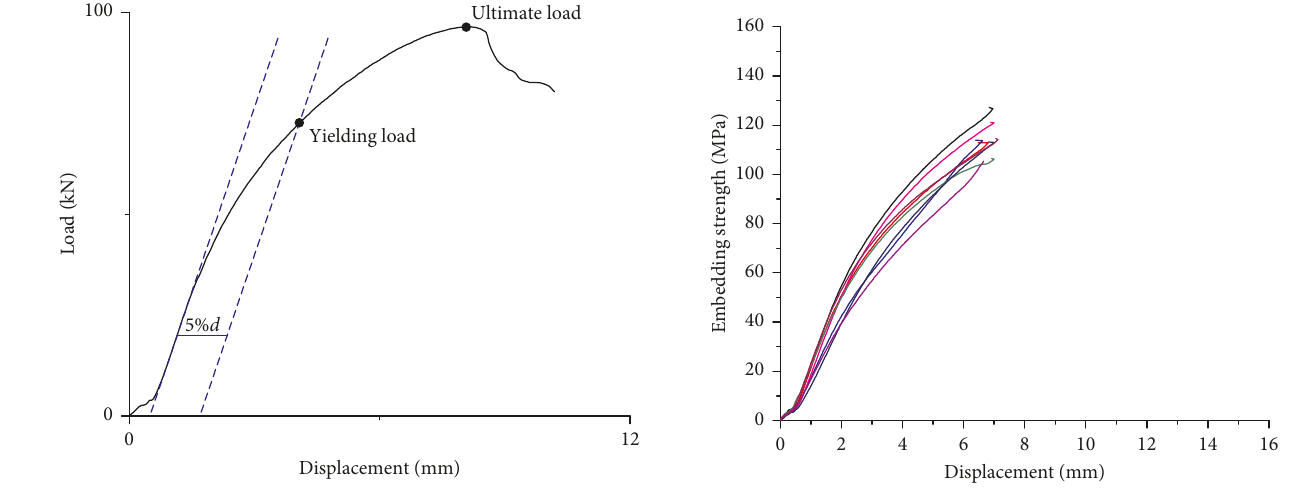
Figure 8: Strength-displacement curve of group